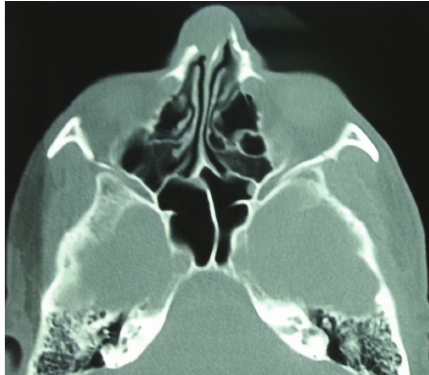
Figure 2: Heterogeneous density cystic mass destroying the nasal bone in the axial tomography of the temporal bone.